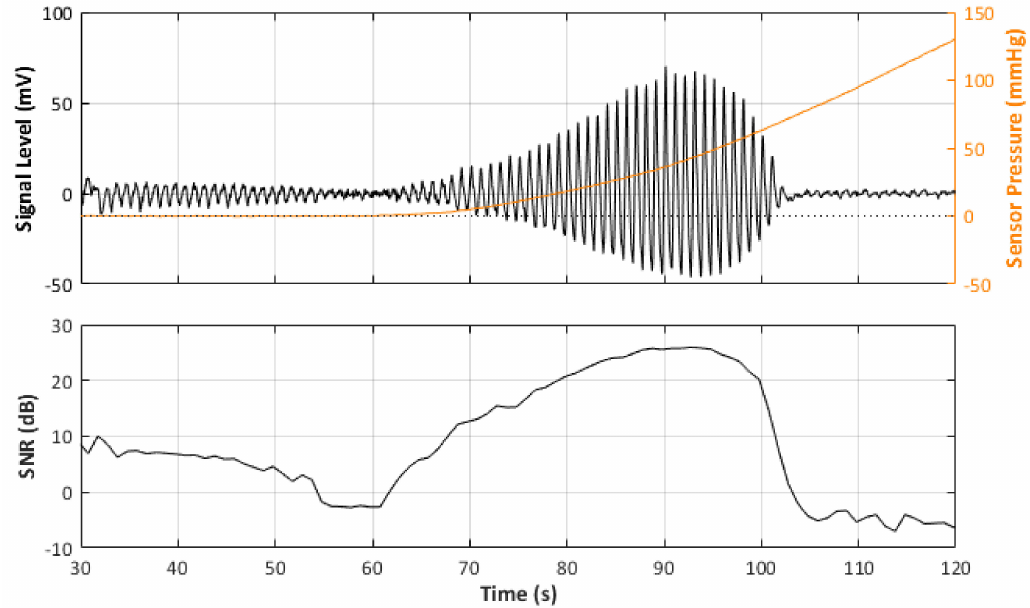
Figure 4. Signal Monitoring example from the experiment. Top plot shows the acquired PPG signal (black line) with the pressure at the probe (orange line). Bottom plot shows the calculated SNR during the pressure increase. Table 4. Measured Maximum SNR and Pressures at each BP state with the standard deviations in parentheses.